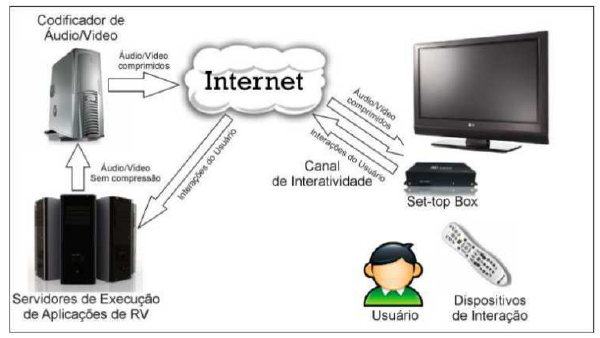
Fig. 10 - DTV Video Streaming over